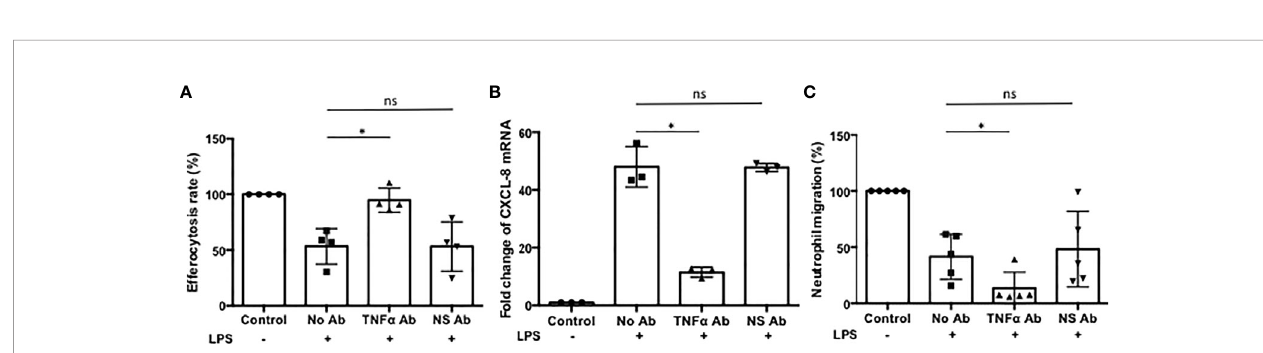
FIGURE 7 | The effect of TNF a on macrophage efferocytosis and neutrophil chemotaxis. Z-MDMs were incubated with LPS (10 ng/ml) and TNF a neutralizing antibody overnight. (A) The effect of TNF a neutralizing antibody on neutrophil efferocytosis by MDMs was examined (n=4). For each Z-MDM individual sample, the efferocytosis rate of control MDM was set to 100%, and the efferocytosis rates of the other three treatments were normalized to control MDM. (B) The relative expression levels of CXCL-8 in the LPS-treated cells were calculated in comparison to their non-treated controls (n=3). The CXCL-8 expression level of control MDM was set to 1, and the CXCL-8 expression levels of the other three treatments were normalized to control MDM. (C) Conditioned media of Z-MDM samples were collected for neutrophil chemotaxis assay (n=5). The number of migrated neutrophils was counted, and neutrophil migration rate was calculated based on the number. The migration rate of control MDM was set to 100%, and the migration rates of the other three treatments were normalized to control MDM. *Denotes statistical signi fi cance (p-value < 0.05) according to two-tailed Student ’ s